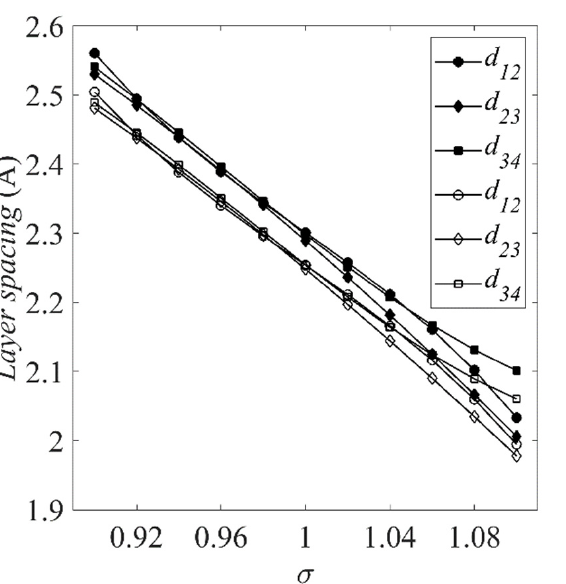
Figure 5. Layer spacings of the clean Pt(111) slab shown in Figure 3b. The filled (solid) symbols correspond to results obtained using the GGA; the unfilled (clear) symbols correspond to those obtained using the LDA.